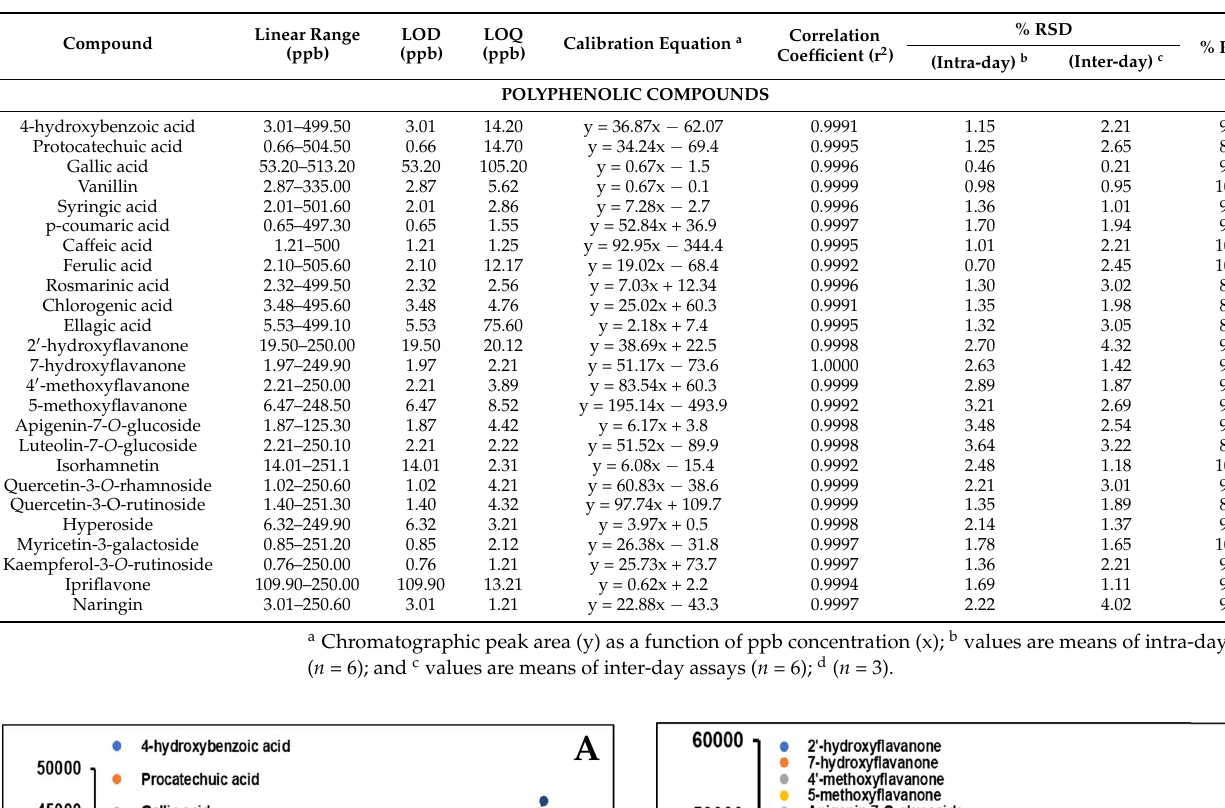
Table 1. Limits of detection (LOD), quantification (LOQ), linearity, precision, and accuracy for all screened polyphenols. Calibration equations represent peak areas as a function of concentration (ppb). Intra- and inter-day experimental data were collected over a 6-day experiment, while % recovery data represent three independent experiments.